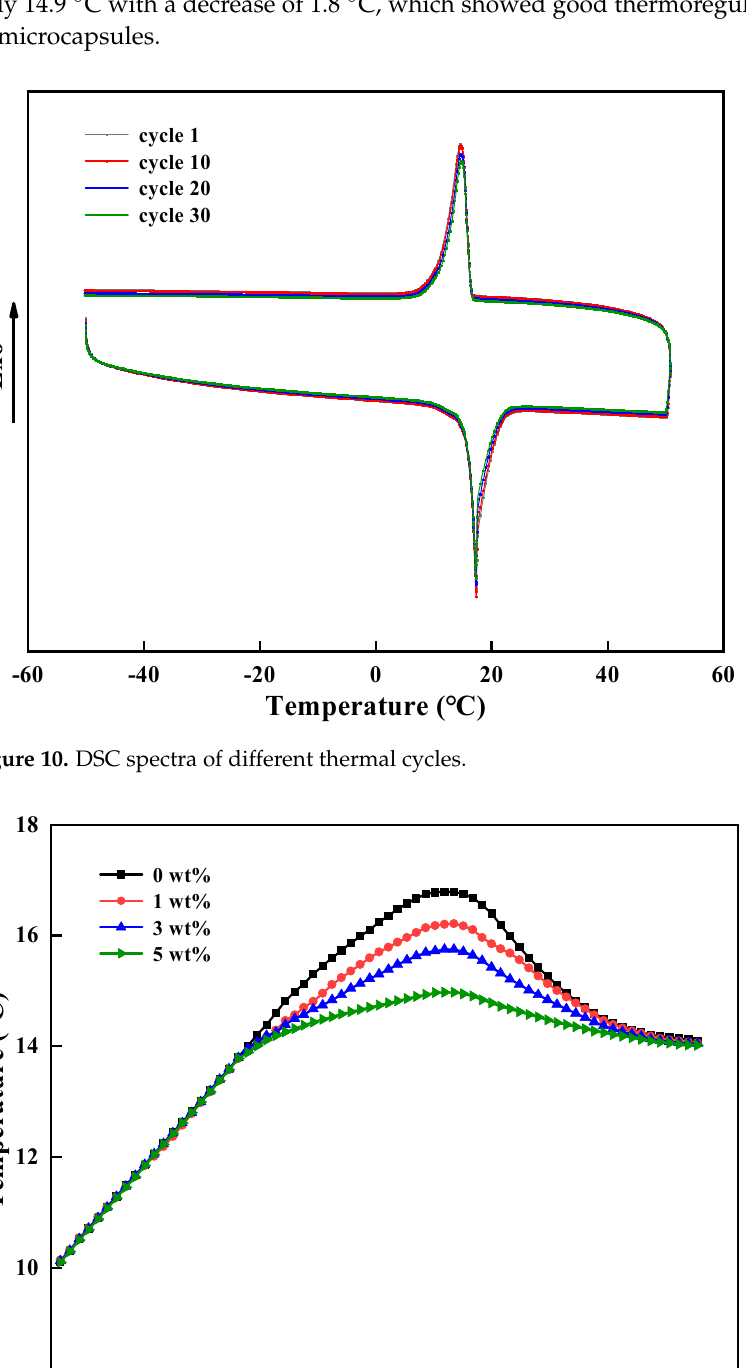
Figure 9. Relationship between encapsulation efficiency and thermal conductivity.